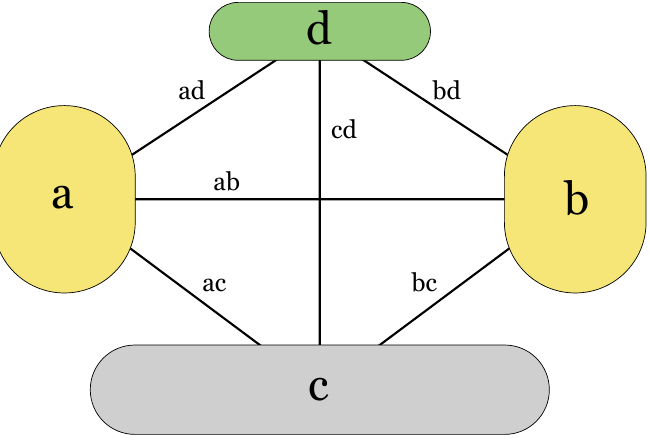
Figure 2. System of connected networks in our case study. Notations correspond to Table 1, Column